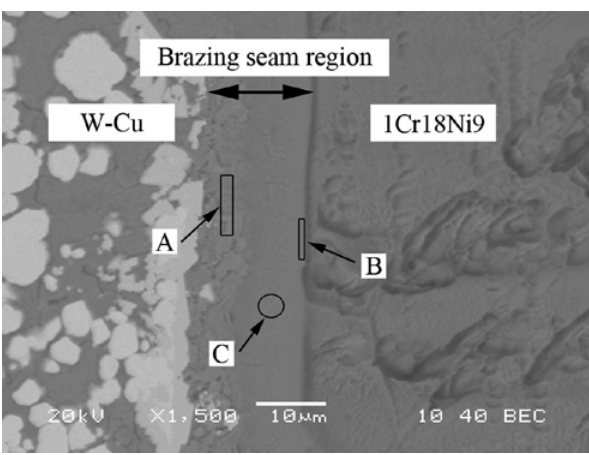
Figure 2: Microstructure and feature regions of the NiMnSiCuZr brazed